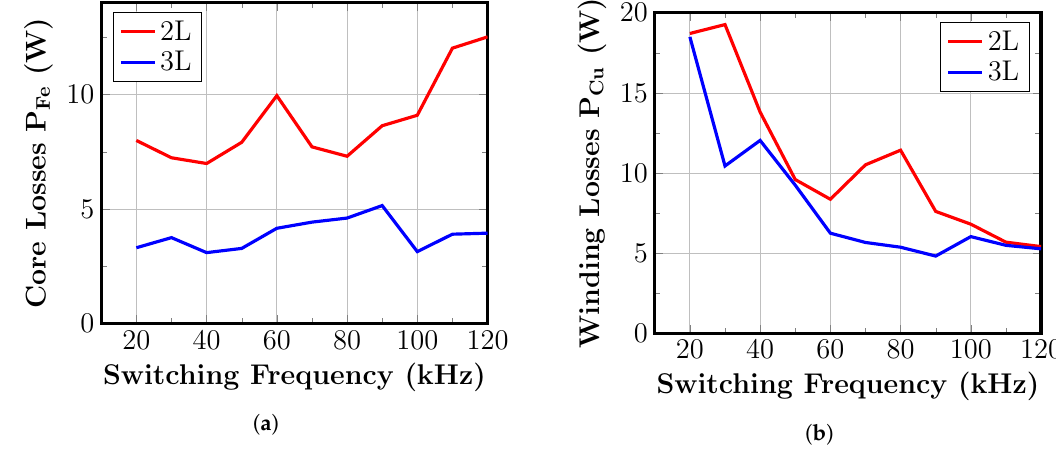
Figure 17. ( a ) Core losses of an individual coupling inductor as function of the switching frequency ( b ) Winding losses of an individual coupling inductor as function of the switching